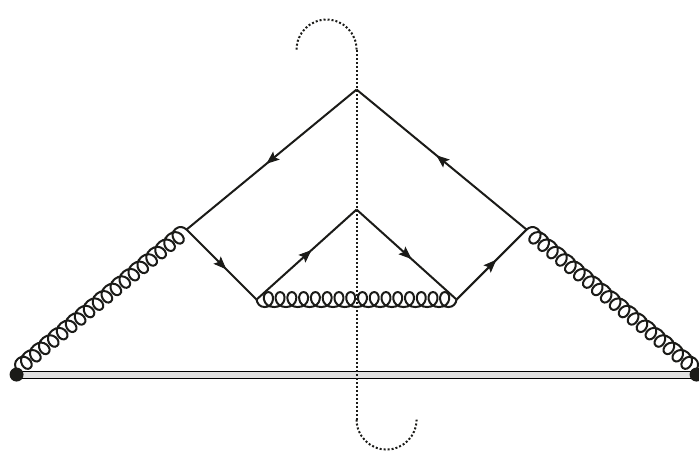
Figure 1 . One of the 4 cut diagrams for gluon fragmentation into a color-octet 1 S 0 Q (cid:22) Q pair at leading order in (cid:11) s . The eikonal line is represented by a double solid line. The dotted line is the cut. The other 3 cut diagrams at leading order are obtained by interchanging the two gluon vertices on each side of the